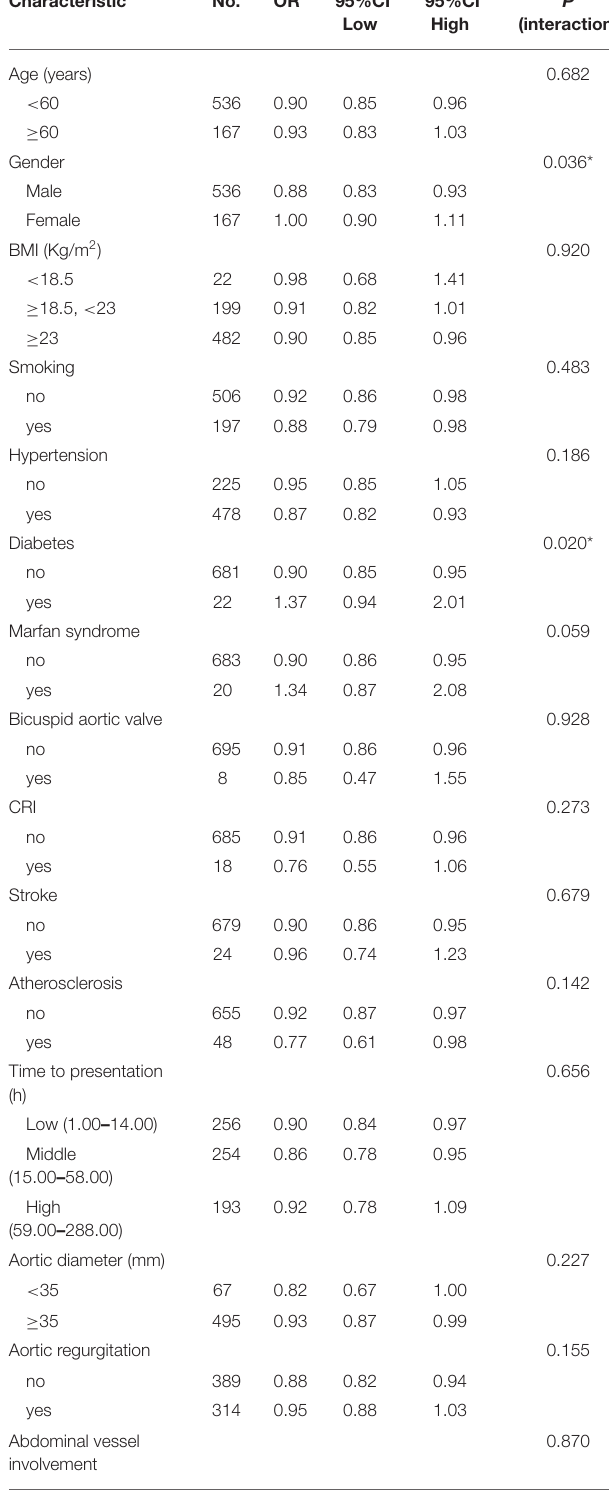
TABLE 5 | Results of subgroup analysis and interaction analysis (SBP per 10